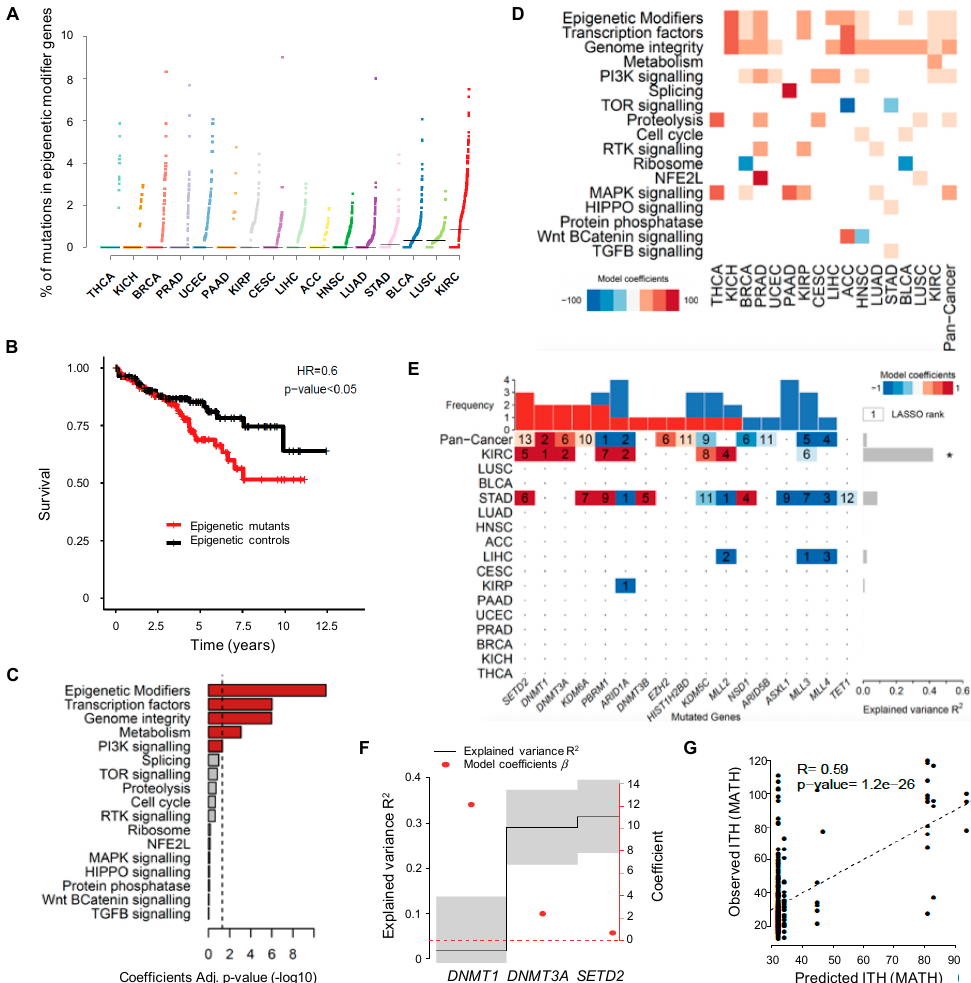
Figure 2. Driver mutations of pan-cancer ITH. ( A ) Pan-cancer analysis of the percentage of somatic mutations in epigenetic modifier genes across 16 TCGA cancer types. The vertical axis shows the percentage of mutations in epigenetic modifier genes whereas the different cancer types are ordered on the horizontal axis from the lowest to the highest percentage of mutations in these genes. ( B ) Kaplan-Meier plot comparing the survival of KIRC patients segregated according to the presence (red) or absence (black) of mutations in epigenetic modifiers. The log-rank test was used for statistical analysis. ( C ) Statistical significance ( − log 10 Benjamini-Hochberg Adj. p -value) of the linear model coefficients estimated for each gene group in KIRC. The vertical dashed line corresponds to the significance level (BH adj. p -value of 0.05). ( D ) Heatmap of the linear model coefficients estimated for each cancer type and gene group. Only statistically significant coefficients are represented (BH adj. p -value < 0.05). ( E ) Heatmap of driver mutations of ITH across several cancer types depicted by a LASSO penalized model. LASSO-selected coefficients are colored according to the effect of each standardized covariate in the optimal model. The numbers on each tile denote the order in which variables are included indicating their relative importance. The top bar plot indicates the frequency at which each driver-gene mutation occurs in the ITH fitted model. The right bar plot shows the explained variance. An asterisk (*) denotes models where the explained variance (R 2 ) is greater than zero by a margin of more than one standard deviation. ( F ) Variance explained by selected driver genes (black line ± 1 standard deviation) ordered by their occurrence in a LASSO penalized model for ITH in KIRC using only the mutated genes DNMT1 , DNMT3A and SETD2 . The optimal model maximizes the explained variance R2. The right axis indicates the effect of each standardized covariate in the optimal model (red dots). ( G ) Scatter plot of predicted and observed ITH for KIRC (Estimate and statistical significance of the Pearson correlation are